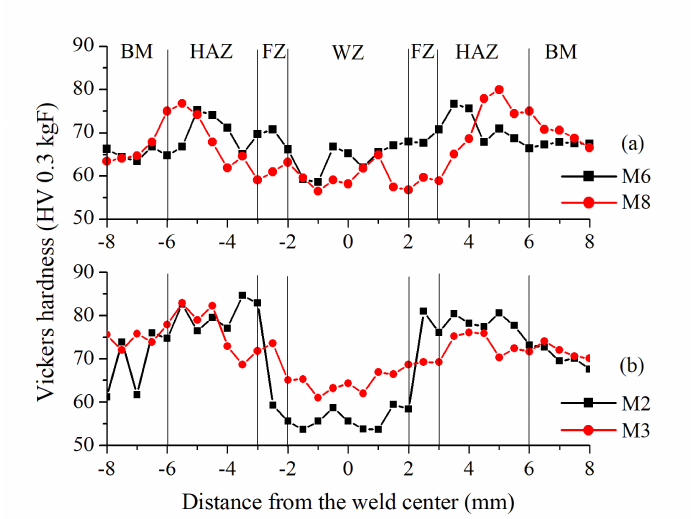
Figure 9. Microhardness profiles for selected samples based on tensile strength performance: ( a ) M6, the best sample, and M8, the worst sample from AA6061–T4 alloy and ( b ) M2, the best sample, and M3 the worst sample from AA6061–T6